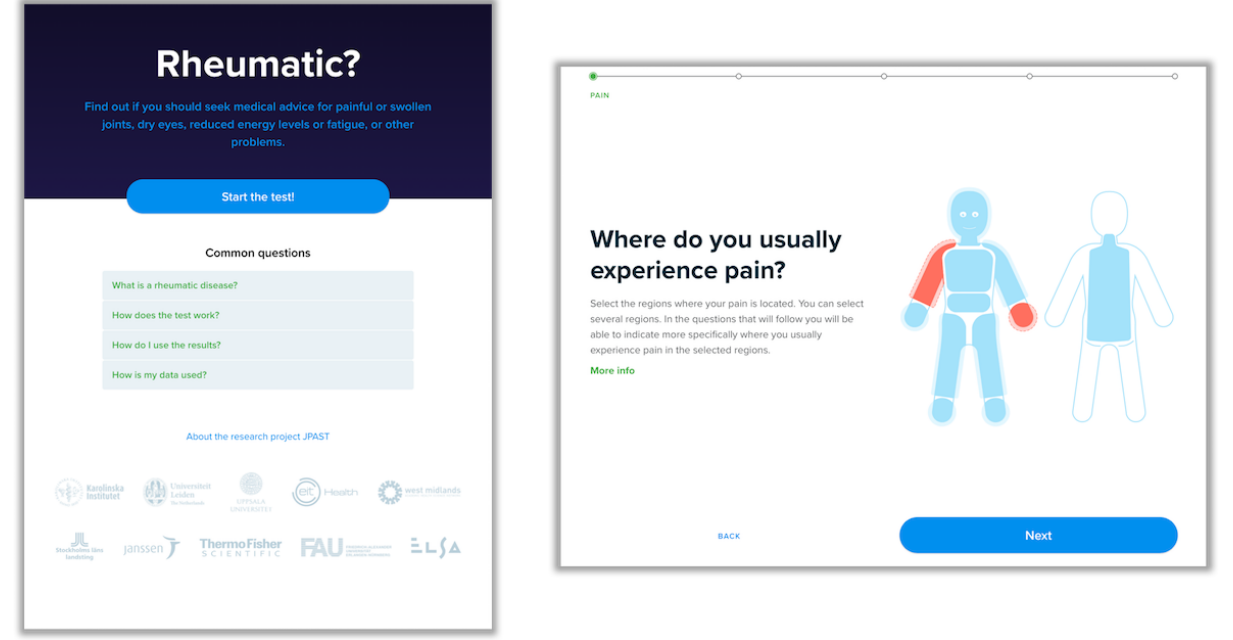
Figure 3. Screenshots of "Rheumatic?" the JPAST (Joint Pain Assessment Scoring Tool) symptom